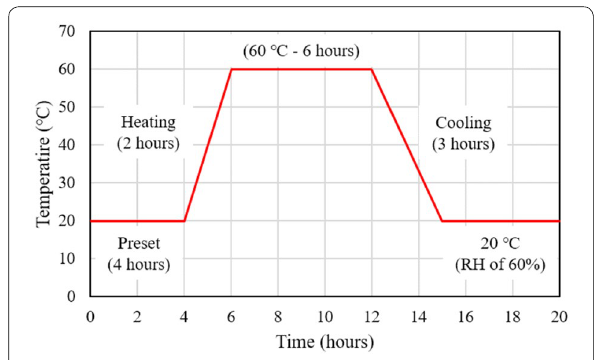
Fig. 1 Details of the temperature history for steam